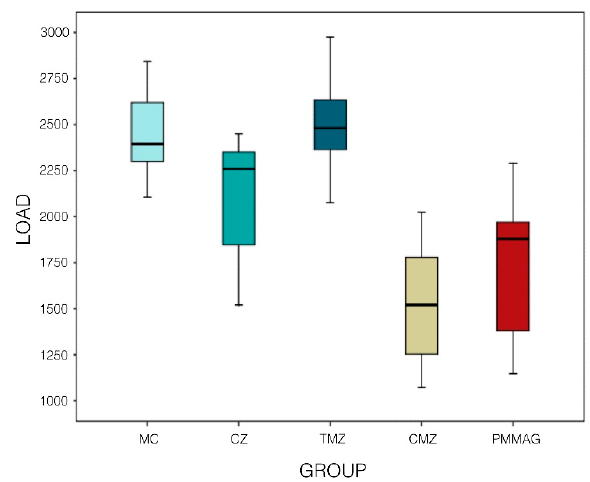
Figure 4. Box-plot shows fracture resistance in different